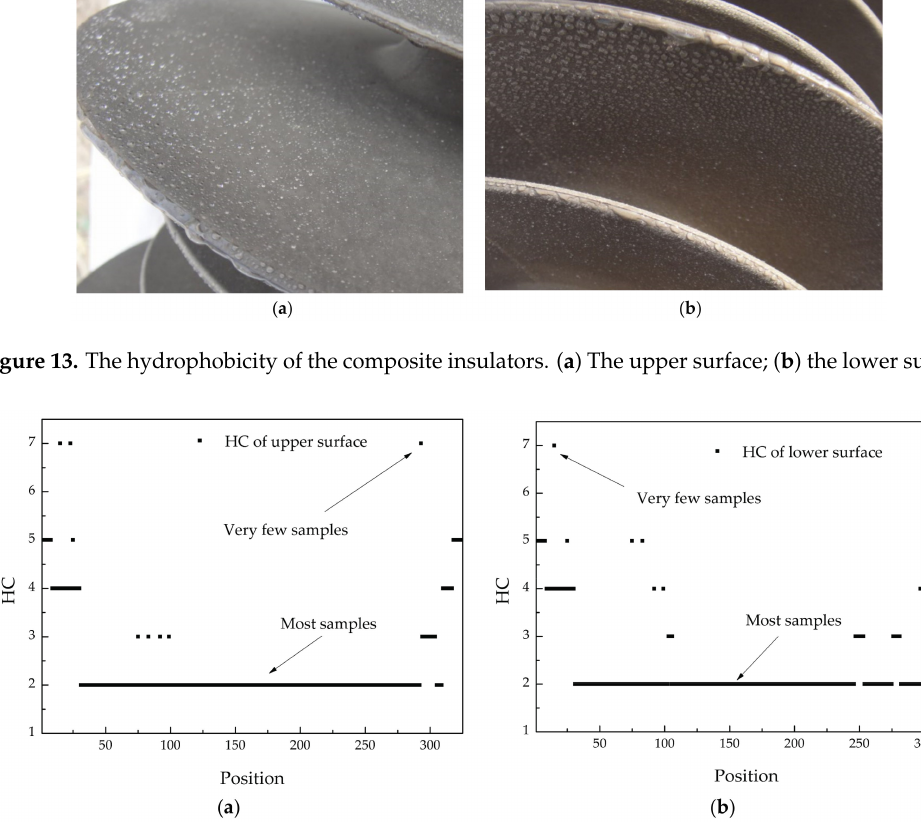
Figure 14. The hydrophobicity of the composite insulator. ( a ) The upper surface; ( b ) the lower